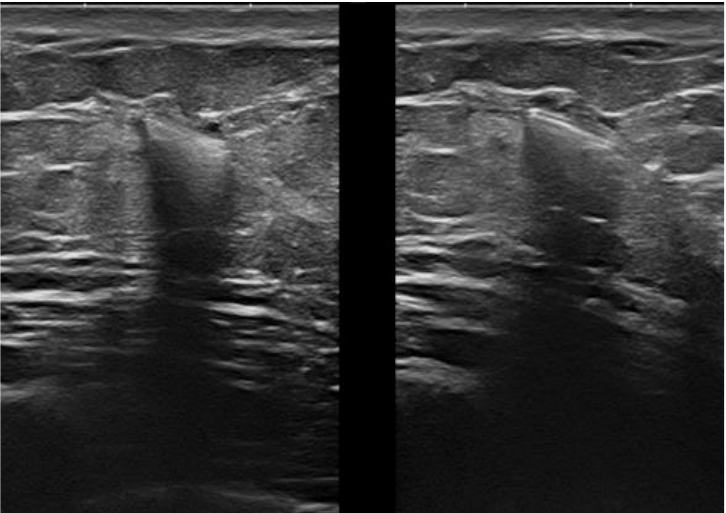
Figure 2. Surgical resection for breast cancer, split screen mode. Detailed depiction of the scarring, with the optimal display of a surgical clip causing reverberation artifacts.